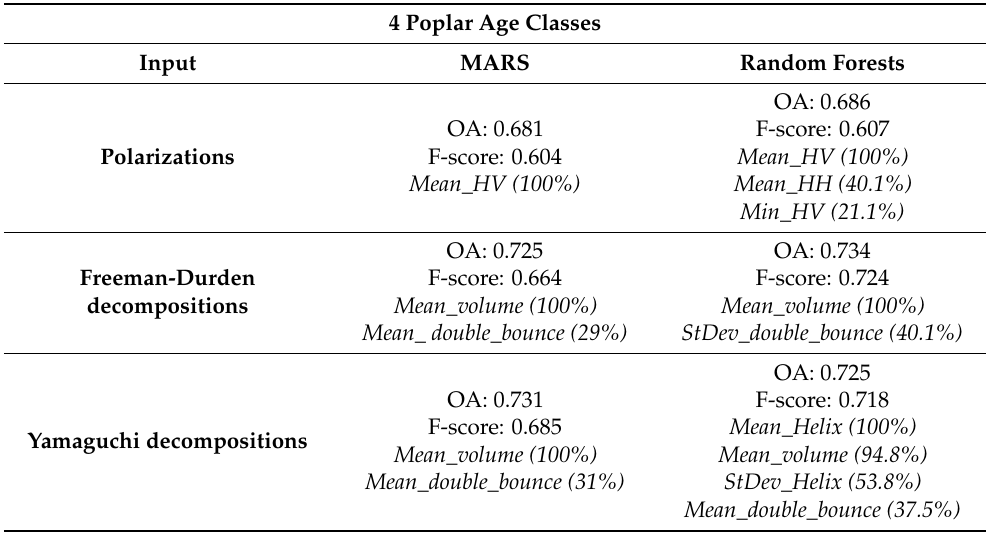
Table 1. Overall accuracy (OA) and F-score for the classification of 4 poplar age classes with MARS and Random Forests models. The predictors contributing >20% to the result are reported in